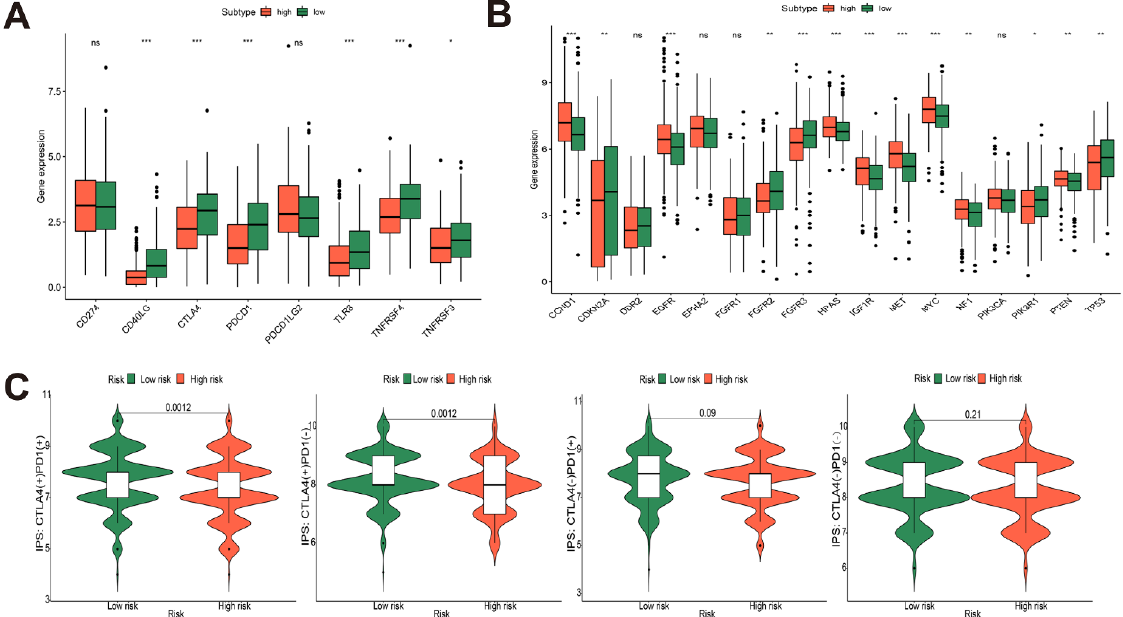
Figure 6. Immune-related gene analysis of risk model and prediction of immunotherapy efficacy in TCGA-HNSCC cohort. (A, B) The expression of immune checkpoints (A) and targeted genes (B) in high- and low-risk groups; (C) the IPS was compared in high- and low-risk groups . (* p < 0.05, ** p < 0.01, *** p < 0.01).